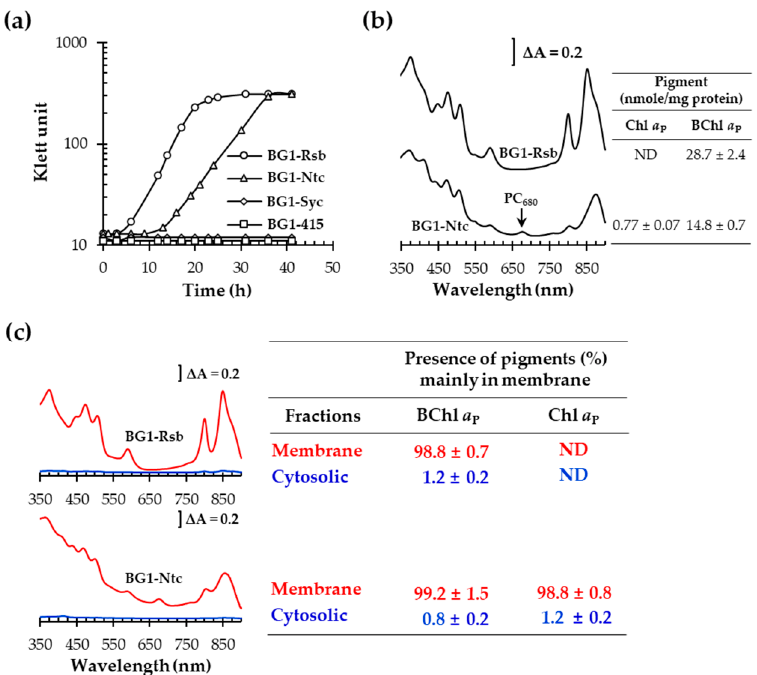
Figure 5. Effects of NtchlG expression on the photoheterotrophic growth of BG1. The photoheterotrophic growth BG1-Ntc ( a ) is shown with the absorption spectrum of the membrane fraction ( b ). BG1-Rsb, BG1-Syc, and BG1-415 were used as controls. Pigments were extracted from the membranes and quantified by HPLC; the obtained results are listed on the right side of the corresponding spectra ( b ). Membrane (red) and cytosolic fractions (blue) of photoheterotrophically growing BG1-Rsb and BG1-Ntc were separated and adjusted to the same volume as that (2 mL) used for resuspension of cells harvested for the analysis of absorption spectra ( c ). Pigments were extracted from the membrane, and cytosolic fractions and the relative levels of BChl a P and Chl a P were quantified by HPLC ( c ). BChl a P and Chl a P were detected at low levels in cytosolic fractions, which were as- cribed to the contaminated membrane debris. ND, not detected.